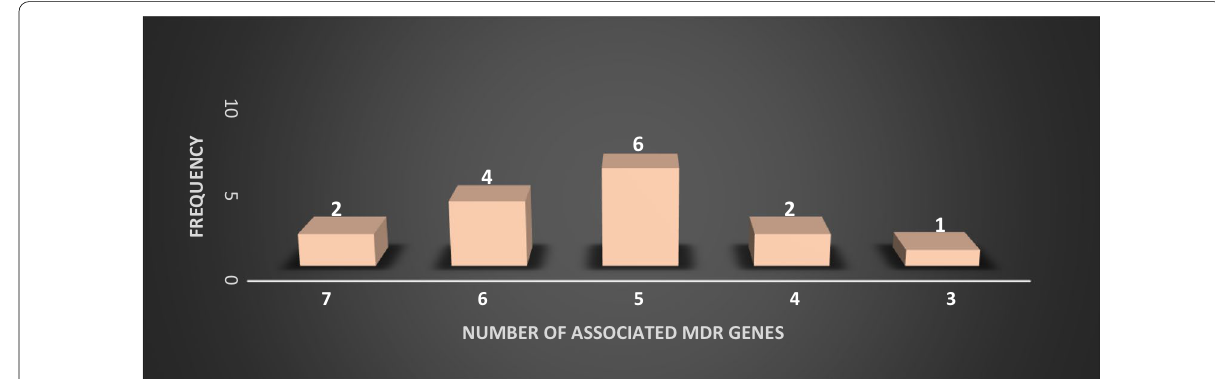
Fig. 2 Frequency of association in determinant genes for MDR occurrence within the strain